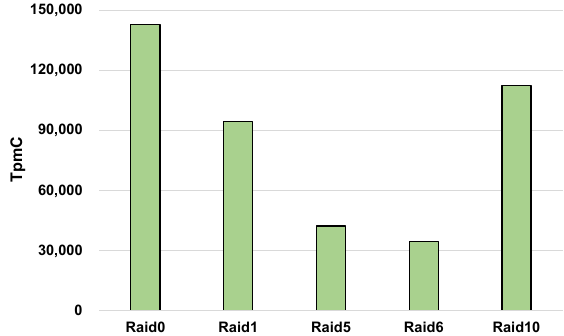
Figure 8. Experimental results under the TPC-C